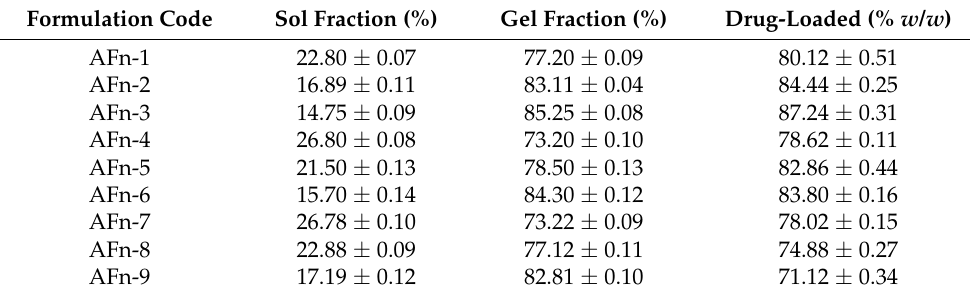
Table 1. Sol–gel analysis and % drug loading of ASPA-pAMPS microgels. Formulation